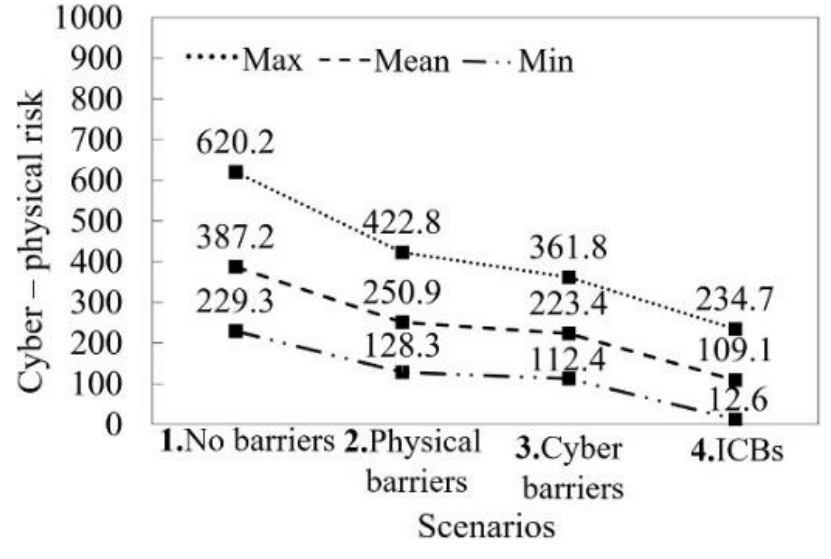
Figure 4. Cyber-physical risk per scenario.